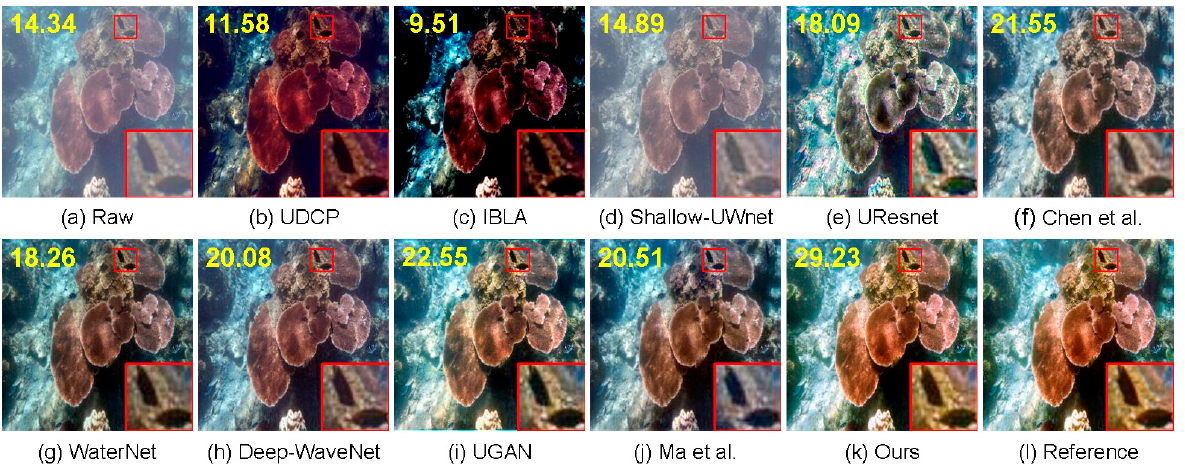
Figure 10. The visual comparisons of various UIE approaches on shallow water images. The number on each image represents its PSNR score.